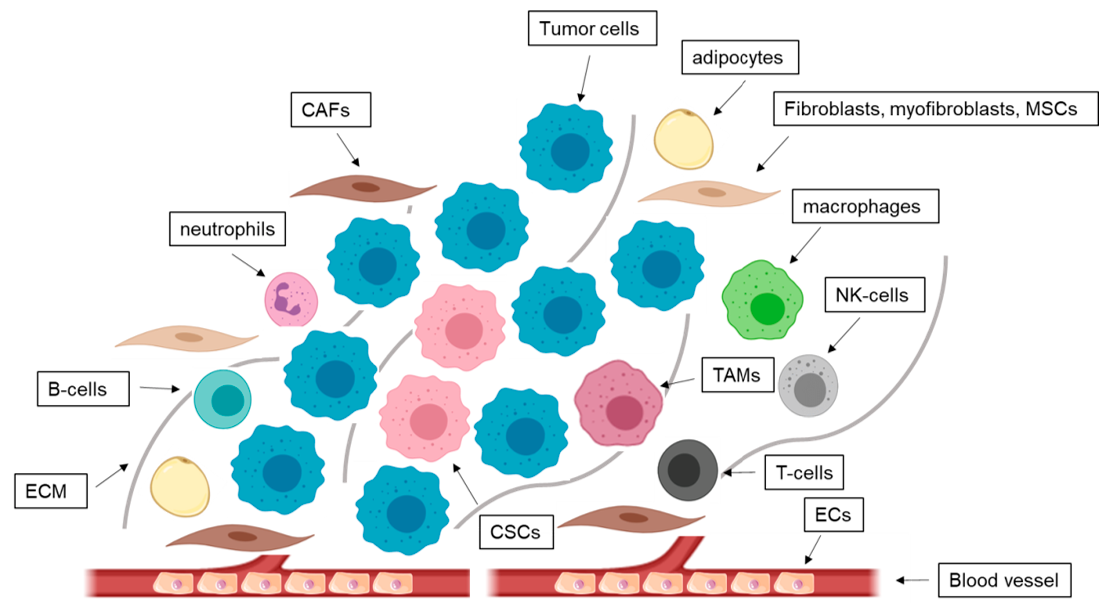
Figure 3. Microenvironment in breast cancer (BCa). The tumor microenvironment consists of numerous cell types like fibroblasts, myofibroblasts, mesenchymal stem cells (MSCs), cancer-associated fibroblasts (CAFs), adipocytes, endothelial cells (ECs), and immune cells like T-cells, B-cells, natural killer (NK) cells, macrophages, tumor associated macrophages (TAMs), neutrophils, myeloid-derived suppressor cells, cancer stem cells (CSCs), and tumor cells. The base of all interactions forms the extracellular matrix